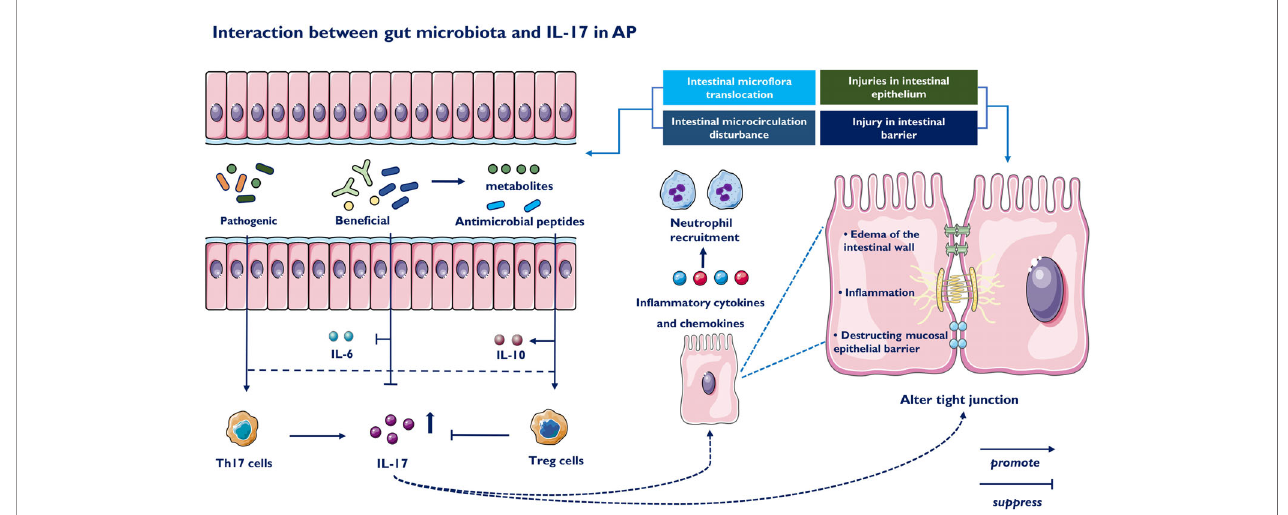
FIGURE 3 | Impact of the gut microbiota on IL-17 and Th17 immune responses. The intestinal microbiota-derived signals to immune cells are classi fi ed into the following three parts: bacterial components, bacteria-derived metabolites and intestinal barrier function. Bene fi cial bacteria suppressed the expression of proin fl ammatory cytokine IL-6 and IL-17 and promoted the expression of major tight junction proteins. On the contrary, colonization of pathogenic commensal bacteria induces generation of Th17 and downregulates Tregs immune responses. Bene fi cial bacteria produce short-chain fatty acids, which participate in the generation of Tregs and IL-10 by suppressing proin fl ammatory cytokines. IL-17 injuries intestinal epithelium, releases in fl ammatory cytokines and cause intestinal microcirculation disturbance. IL-17 also induces impaired intestinal barrier function, including edema of the intestinal wall and destruction of the mucosal epithelial